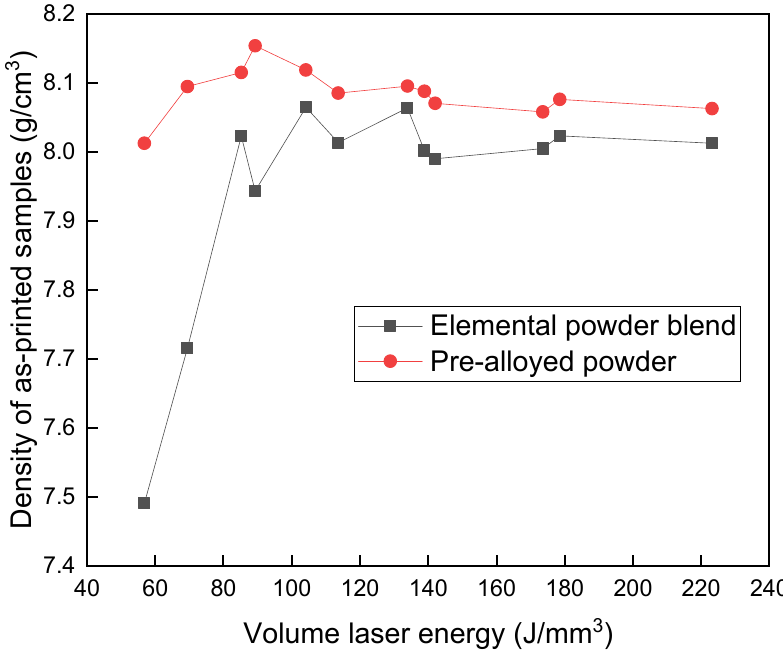
Figure 4. Density variation of as-printed samples.